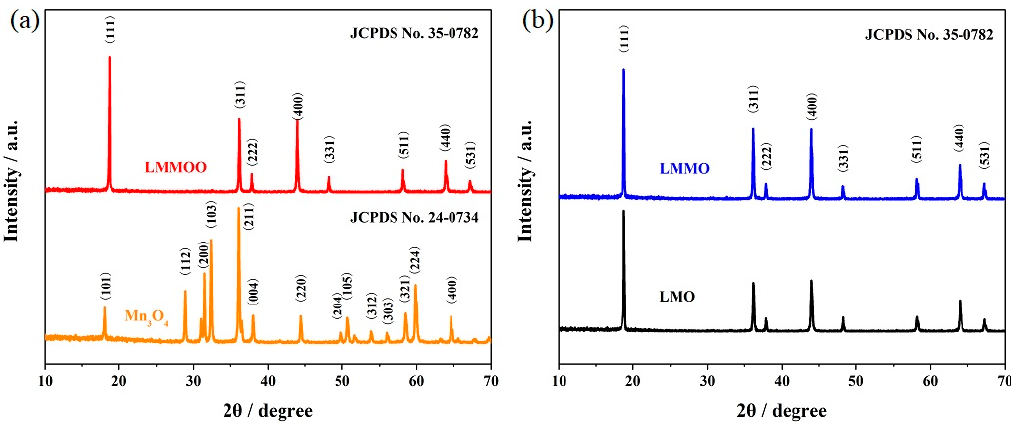
Figure 1. XRD patterns of ( a ) Mn 3 O 4 and octahedral LiMn 1.95 Mg 0.05 O 4 , and ( b ) LiMn 2 O 4 and LiMn 1.95 Mg 0.05 O 4 samples. Table 1. Crystal parameters of the LiMn 2 O 4 and LiMn 1.95 Mg 0.05 O 4 samples.